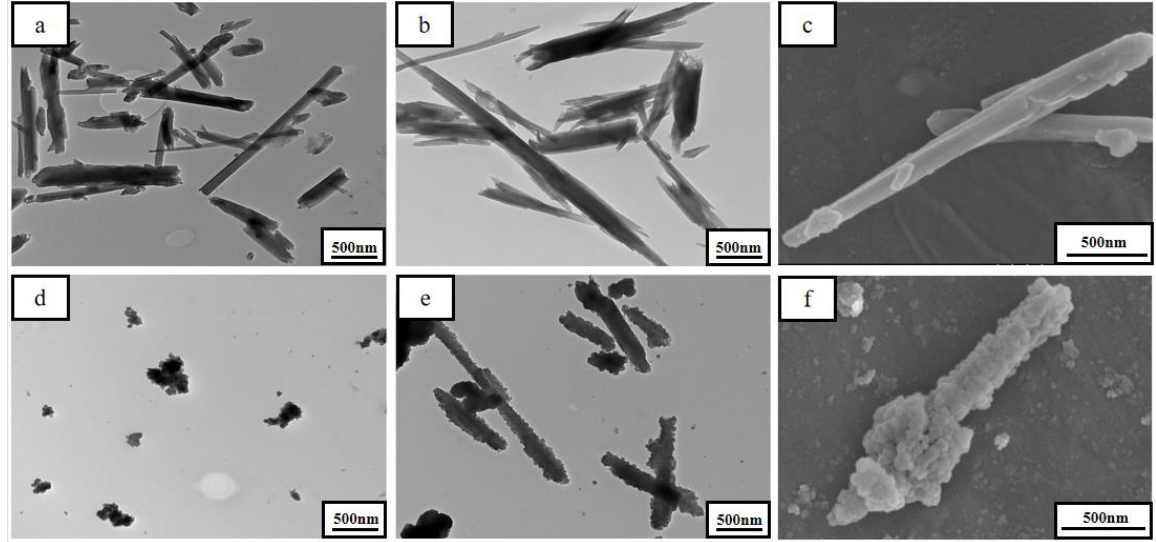
Figure 2. TEM images of HNTs ( a ), HNTs − COOH ( b ), UiO66 − NH 2 ( d ), and H − U ( e ); and SEM images of HNTs − COOH ( c ) and H − U ( f ).